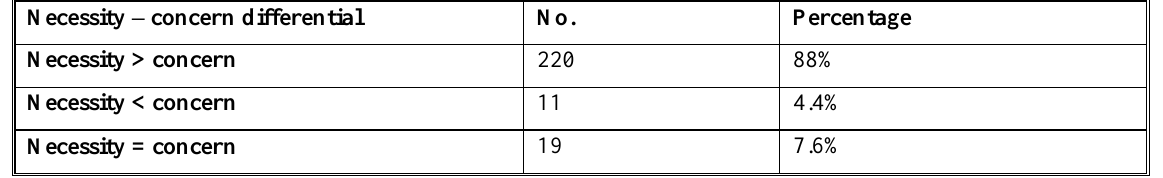
Table 4. Beliefs about medicines questionnaire necessity – concern differential